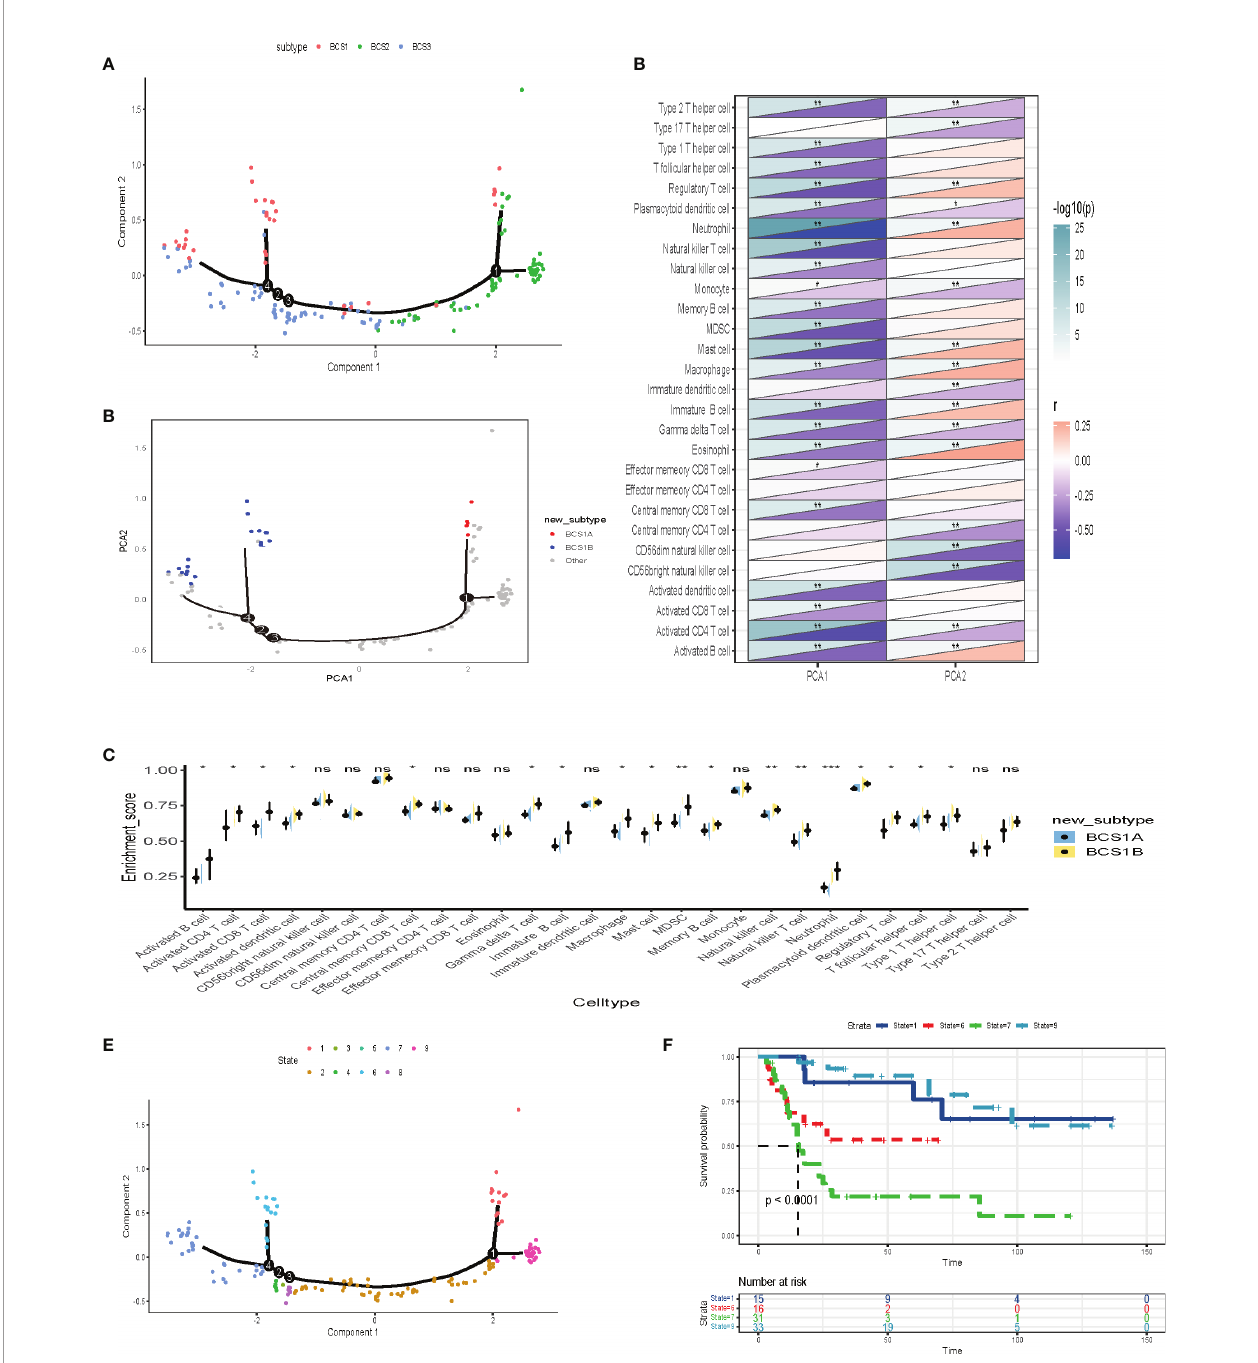
FIGURE 8 | Construction of the immune landscape for BLCA. (A) Each point represents a patient, the immune subtypes are color-coded. The horizontal axis represents the fi rst principal component, and the vertical axis represents the second principal component. (B) Immune landscape of the subsets of BLCA immune subtypes. (C) Heat map of two principal components with 28 immune cell signatures. (D) Differential enrichment scores of 28 immune cell signatures in BCS1A and BCS1B. (E, F) Immune landscape of samples from four extreme locations and (F) their prognostic status. * P < 0.05, ** P < 0.01, *** P <0.001, and ‘ ns ’ represents not signi fi